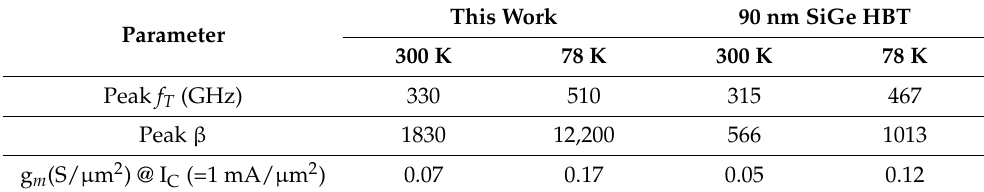
Table 4. The advanced SiGe HBTs figure-of-merit